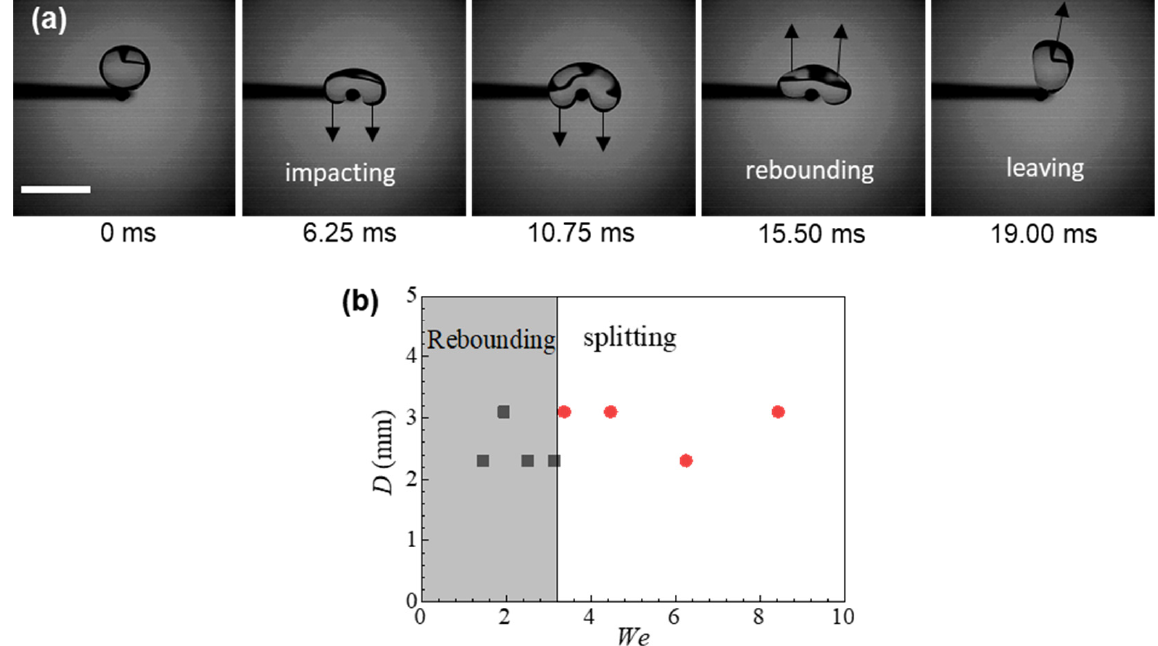
Figure 5. ( a ) Impacting process of a droplet of 5.5 µ L on the superhydrophobic wire at We = 1.4. The impacting velocity of the droplet is v = 0.2 m/s. ( b ) Phase diagram for the rebounding and splitting regimes at varied We for two different droplet sizes ( D = 2.3 and 3.1 mm). The gray area in ( b ) shows the rebounding regime with no splitting phenomenon observed. Scale bar in ( a ) is 3 mm. The arrows in ( a ) indicate the direction of the droplet movement.